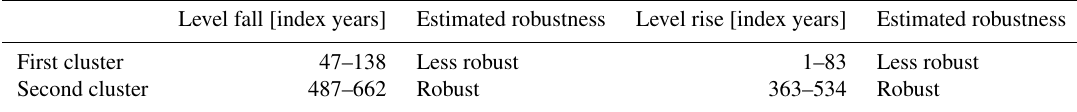
Table 3. Identified clusters in the two studied series following the procedure described in Sect. 3.2 using the number of detrital sub-laminae.